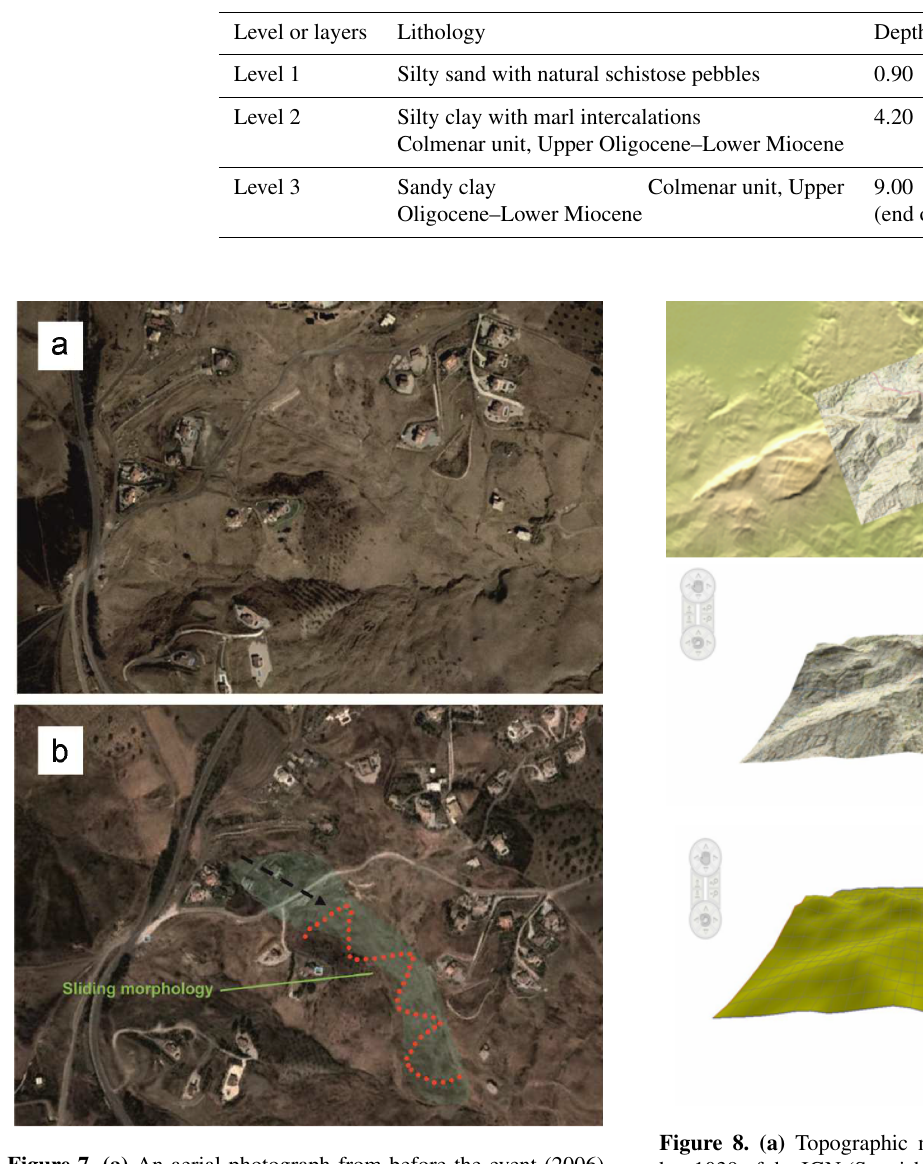
Figure 7. (a) An aerial photograph from before the event (2006). (b) An aerial photograph taken after the landslide (2010).